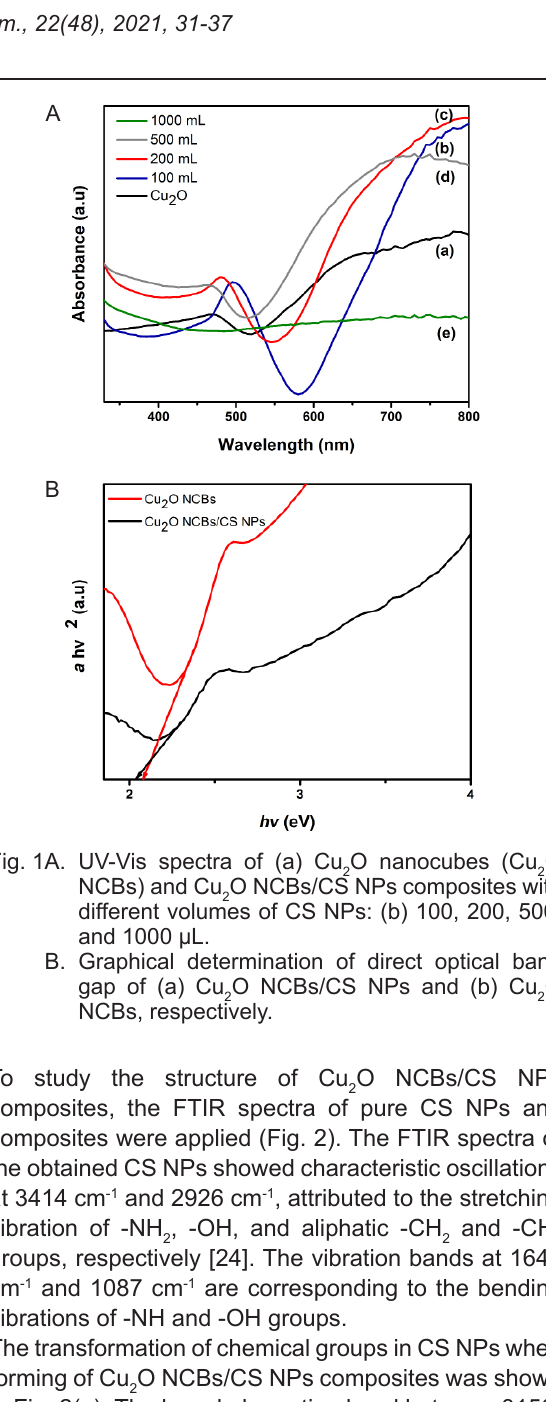
respectively.A Fig. 1A. UV-Vis spectra of (a) Cu O nanocubes (Cu 2 NCBs) and Cu O NCBs/CS NPs composites with 2 different volumes of CS NPs: (b) 100, 200, 500, and 1000 µL. B. Graphical determination of direct optical band gap of (a) Cu O NCBs/CS NPs and (b) Cu 2 NCBs,